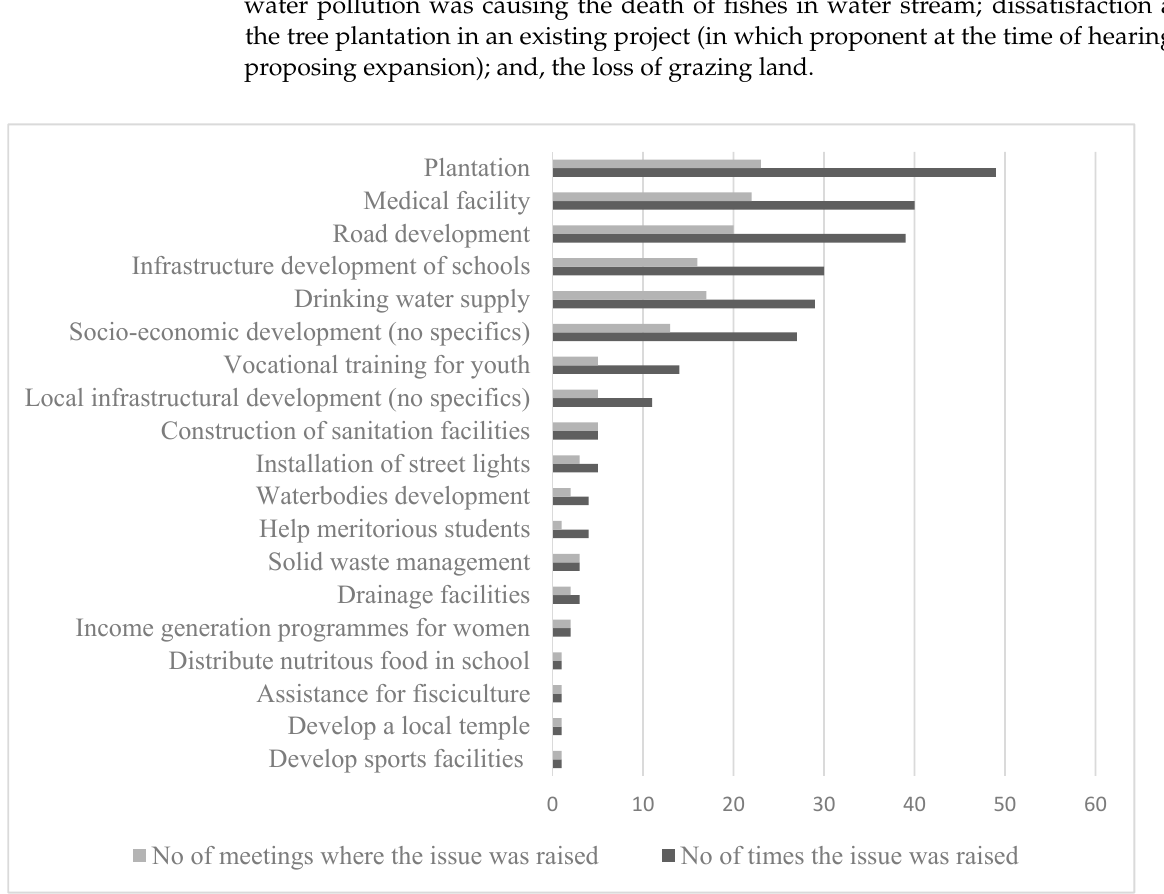
Figure 3. Pollution-related issues raised by people in 50 public hearings.